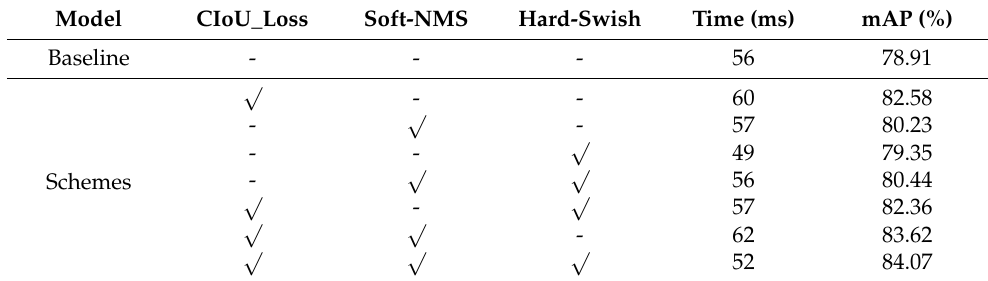
Table 3. Comparison of different improvement